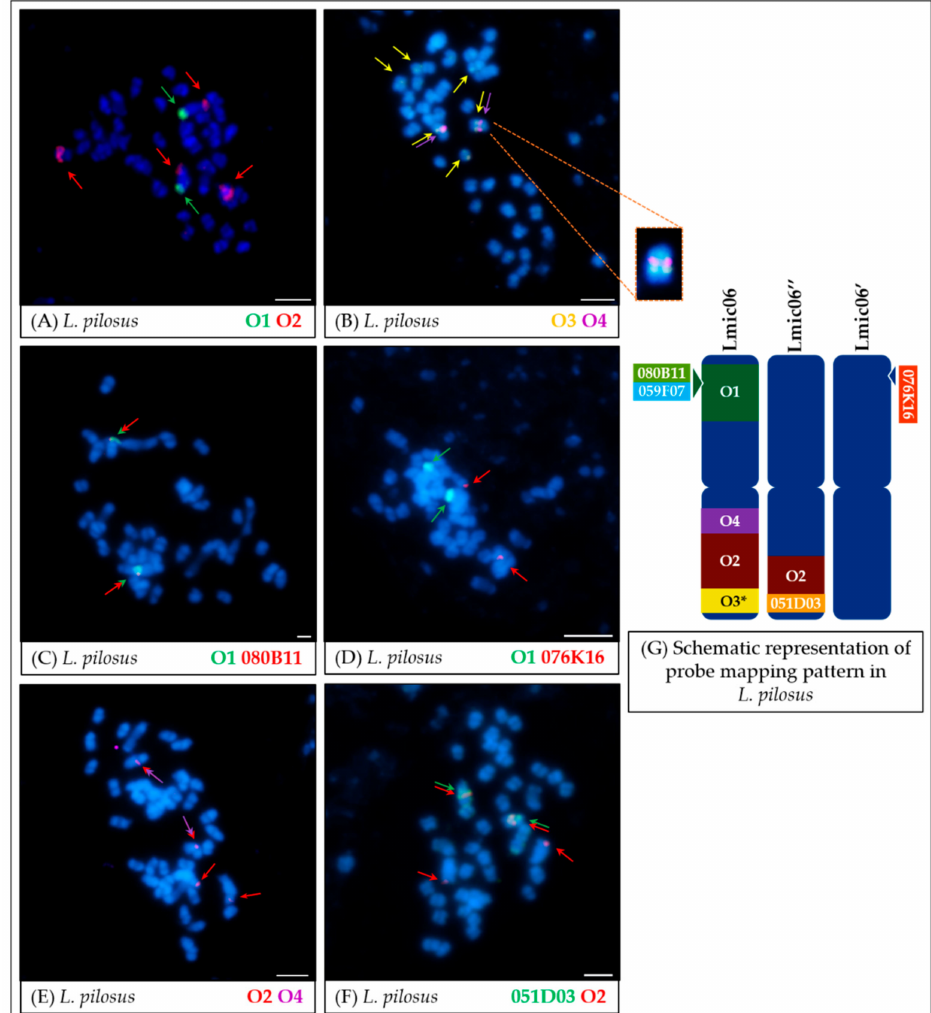
Figure 7. FISH mapping of oligonucleotide probes ( A , B ) and oligonucleotide probes combined with BAC clones ( C – F ) on mitotic chromosomes of L. pilosus . The positions of individual probes are marked by arrows. Probe colors are as follows: green (O1, Lang06 arm A), red (O2, Lang06 arm B), yellow (O3, pericentromeric region of Lang06 arm B), and purple (O4, telomere region of Lang06 arm B). Scale bar: 5 µ m. Schematic representation of probe mapping pattern in L. pilosus chromosomes ( G ), showing observed positions of particular oligonucleotide-based or BAC-based probes, was not drawn to scale. O3*—besides two major loci, minor signals were also noticed. The fragment of Figure 7B showing the intra-chromosomal inversion was magnified (marked with orange, dashed